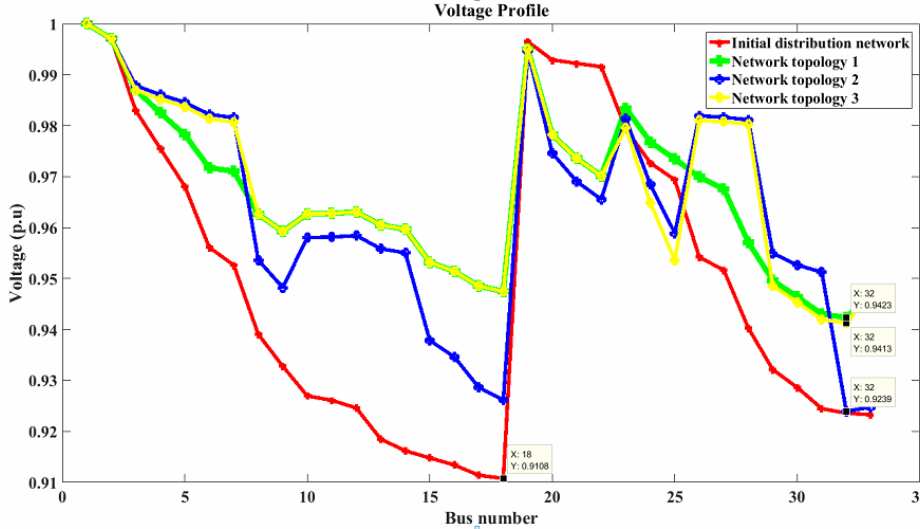
Figure 5. The optimal network topologies’ voltage profiles for the 33 -bus distribution system.